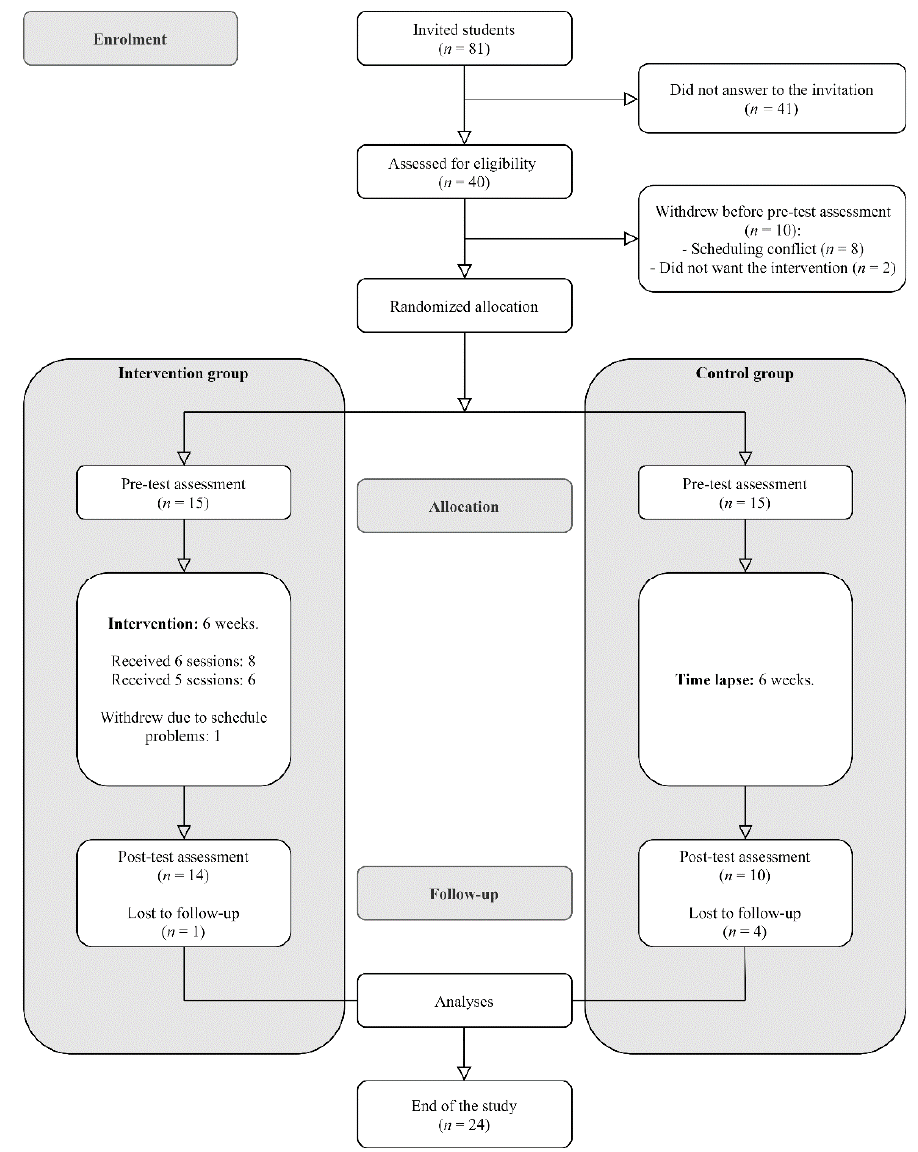
Figure 1. Flow of participants through the trial.